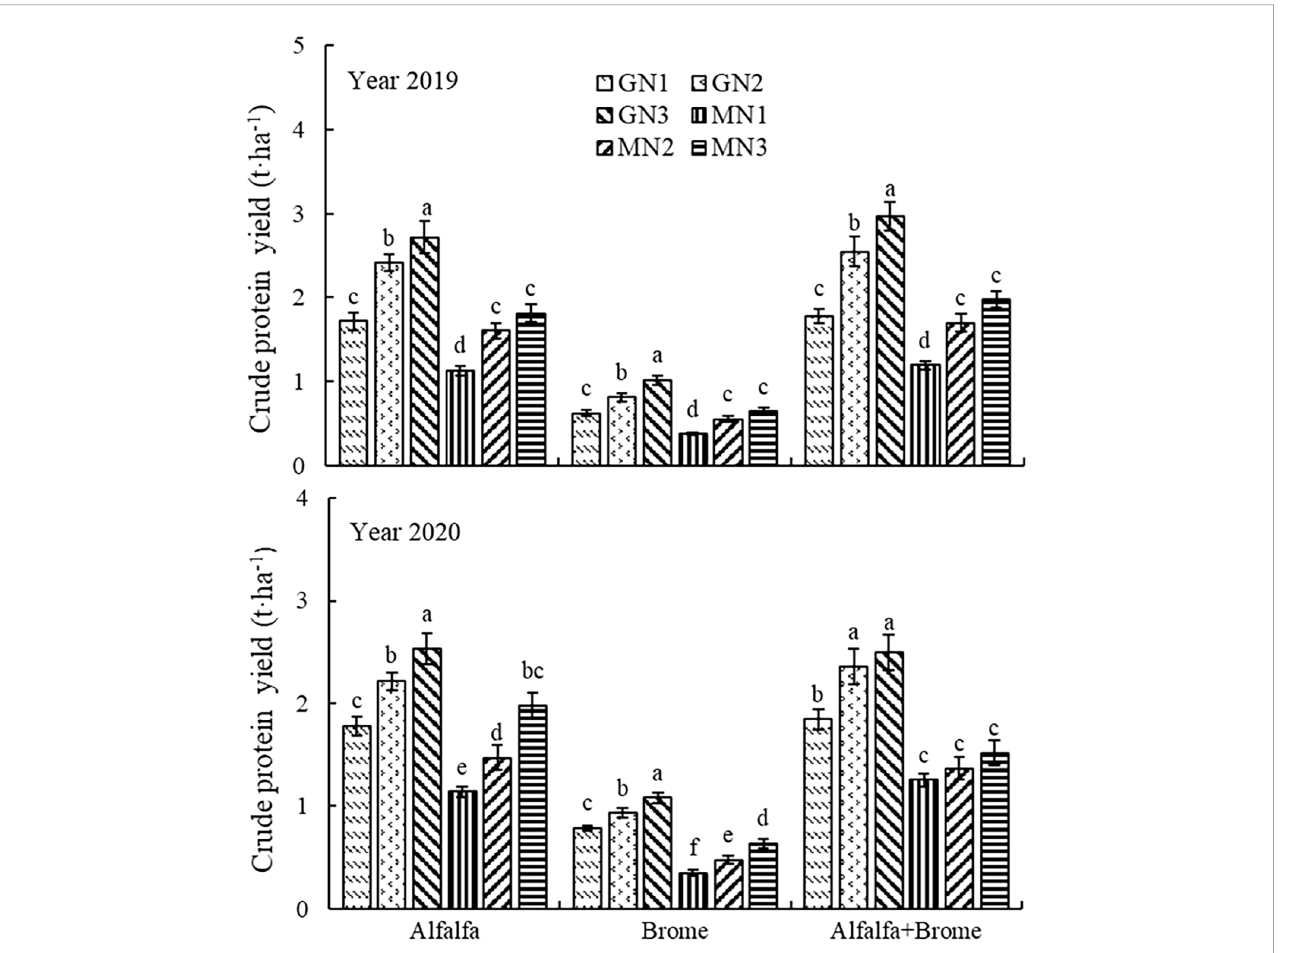
FIGURE 5 Crude protein yield of pasture under different treatments Note: The different lowercase letters indicate a signi fi cant difference among different treatment at P ≤ 0.05. GT denotes grassland type, MM denotes fi eld management measures, and GT×MM denotes the interaction between grassland type and fi eld management measures. The GN1, GN2, GN3, MN1, MN2, and MN3 treatments indicate no nitrogen application under grazing, 80 kg ha -1 nitrogen application under grazing, 160 kg ha -1 nitrogen application under grazing, no nitrogen application under cutting, 80 kg ha -1 nitrogen application under cutting, and 160 kg ha -1 nitrogen application under cutting,